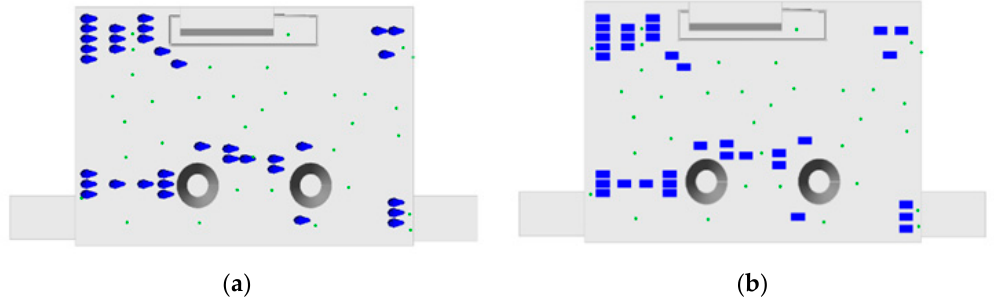
Figure 7. Distribution of two models for broilers: ( a ) body only model, ( b ) block model.